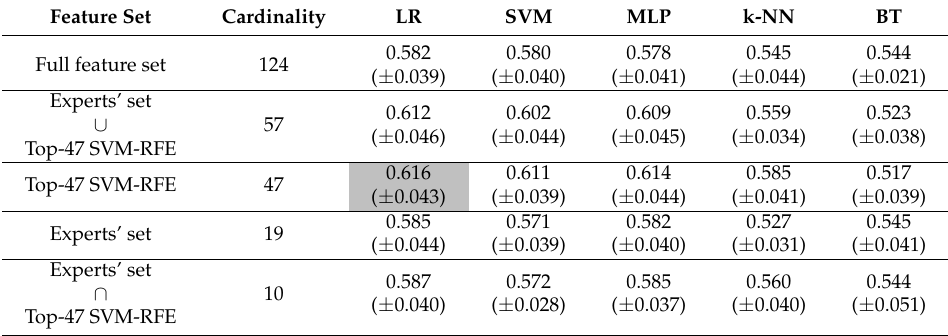
Table 11. AUC for different classifiers with different feature sets. In gray background the best result is shown.